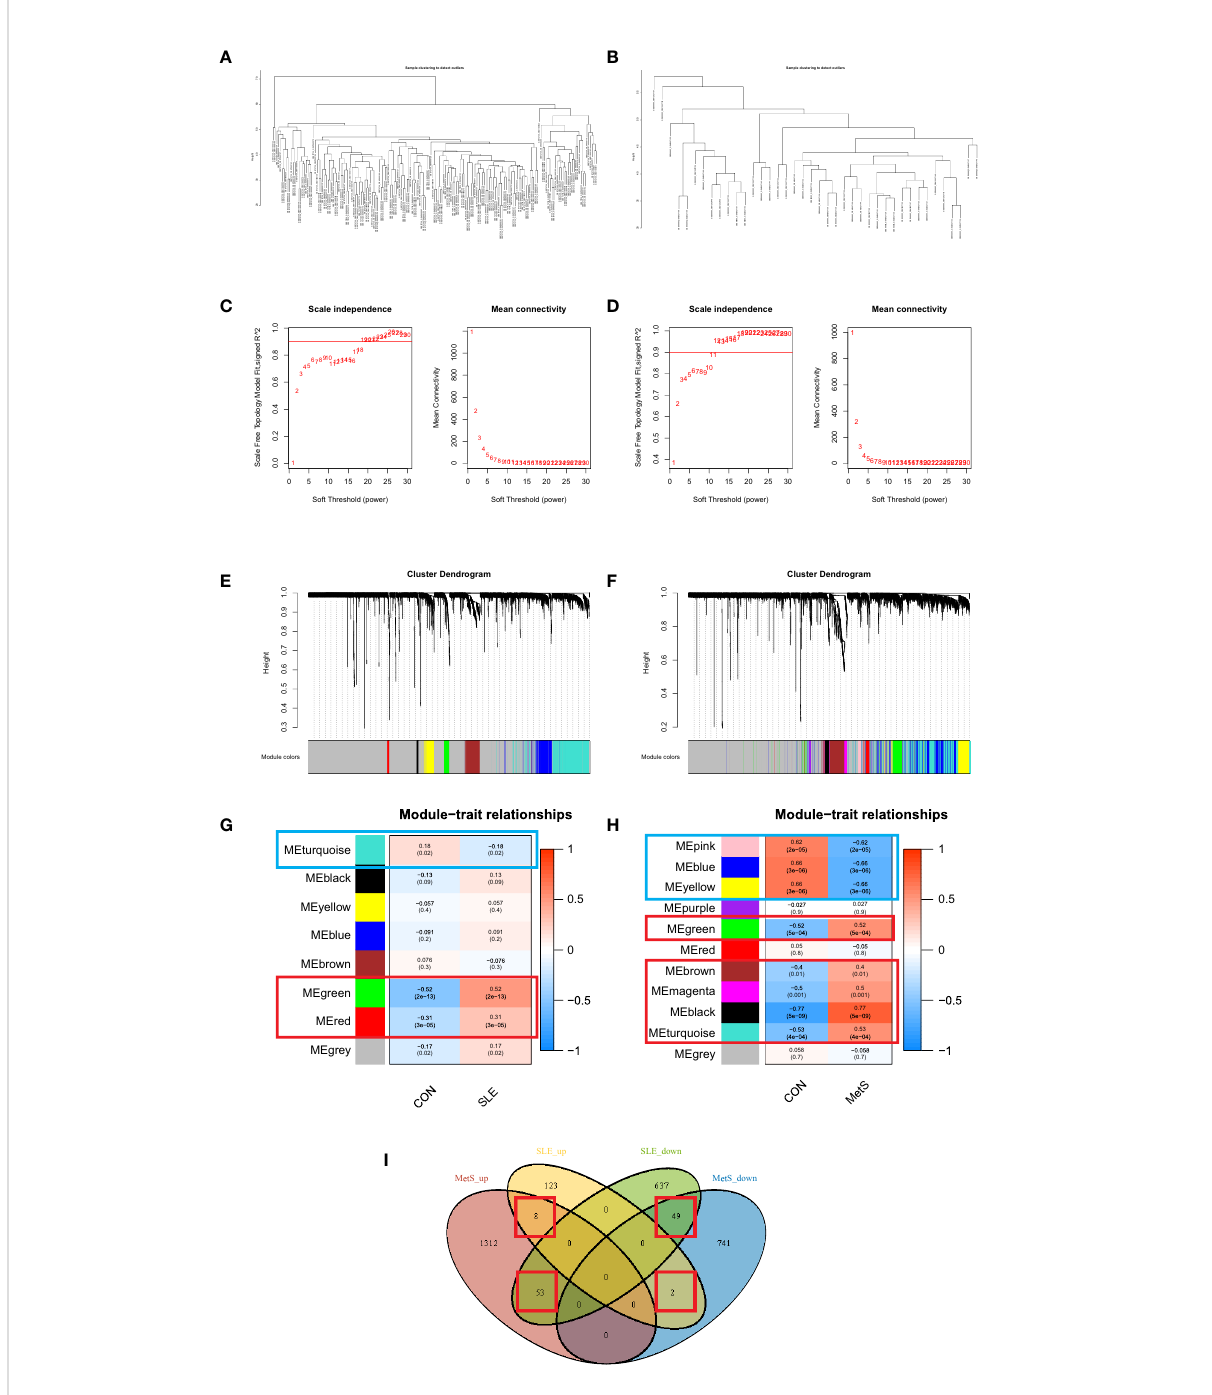
FIGURE 3 (A) Clustering according to the expression level of SLE patients in GSE72326. (B) Clustering according to the expression level of MetS patients in GSE98895. Each branch represents a sample in the data sets, and there is no outlier sample in each data set. (C) Determination of Soft Threshold power for GSE72326. (D) Determination of Soft Threshold power for GSE98895. When scale-free distribution is reached, the optimal soft-power value for GSE72326 was 19 while for GSE98895 it was 11. (E) Origin and merged modules displaying under the clustering tree for GSE72326. (F) Origin and merged modules displaying under the clustering tree for GSE98895. Cluster dendrograms showed the clustering process of the gene modules (G) Heatmap of the correlation between module eigengenes and the occurrence of SLE. (H) Heatmap of the correlation between module eigengenes and the occurrence of MetS. (I) Overlapping module genes of GSE72326 and